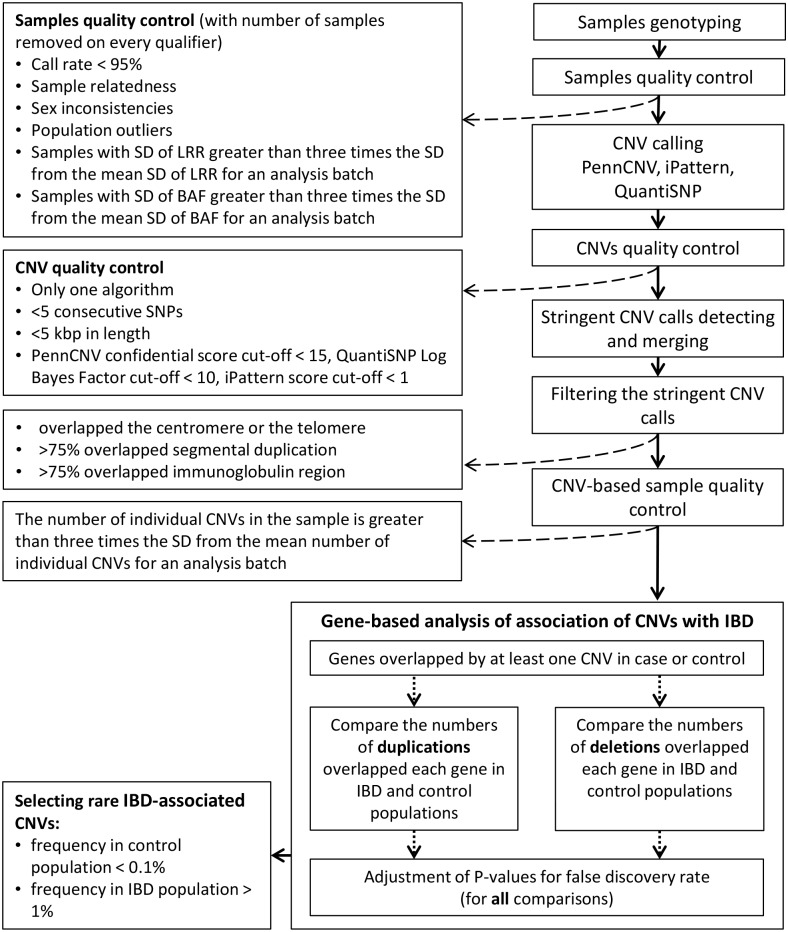
CNV analysis workflow.CNV calling was conducted using variants detected by two or three calling algorithms, which were of sizes greater than 5 kb and spanned at least five array probes. SD: Standard deviation; LRR: Log R ratio; BAF: B allele frequency.